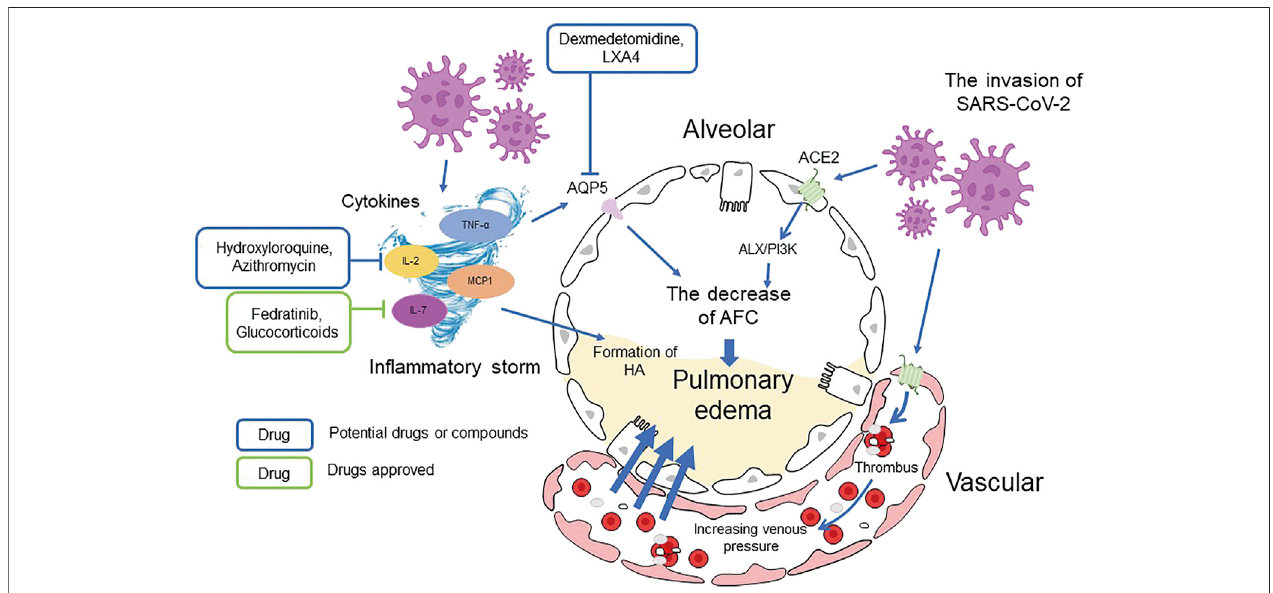
FIGURE 6 | The general regulation approaches of